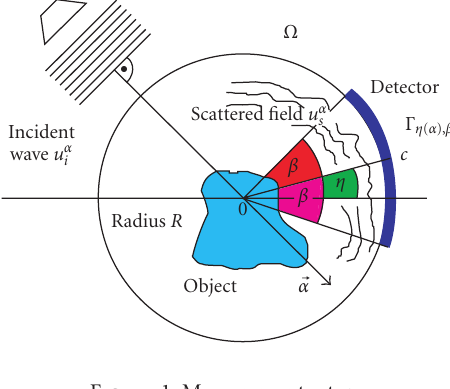
Figure 1: Measurement